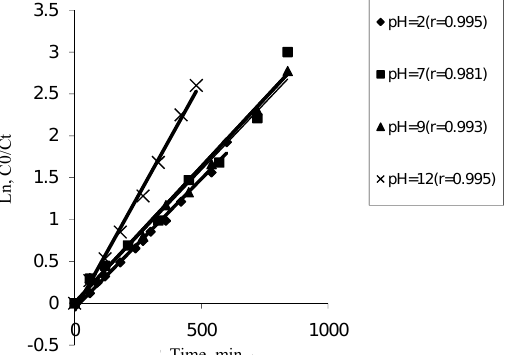
/C ) vs. Time) at various 0 t